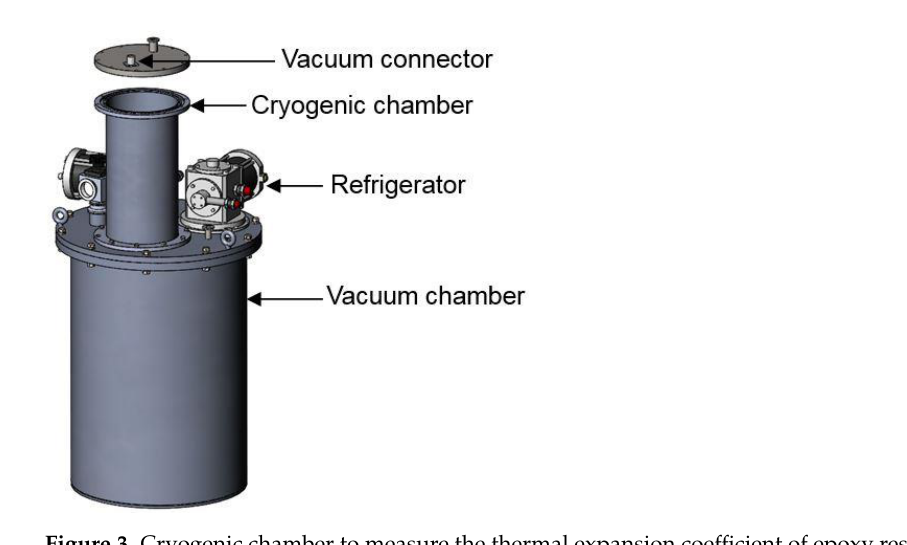
( c ) Figure 2. ( a ) schematic diagram of the test setup, ( b ) the stainless steel mould, and ( c ) the silicone mould. To investigate the thermal shrinkage during cooling down to cryogenic temperature of the epoxy resin with the strain gauge, a device cooled by cryocoolers was designed, as